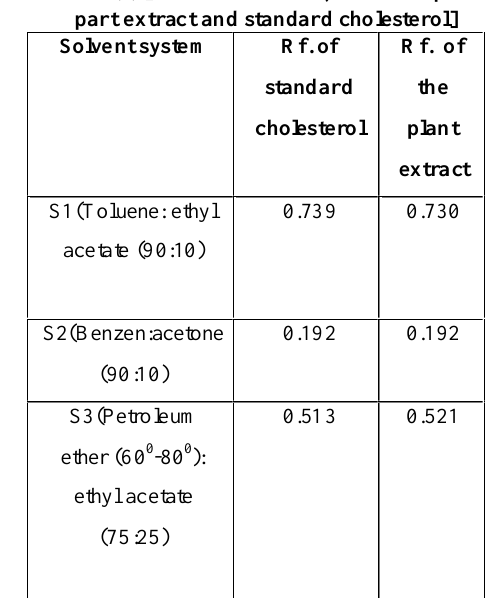
Figure (6) :TLC plate of the aerial plant extract, and standard, using S2 mobile phase)